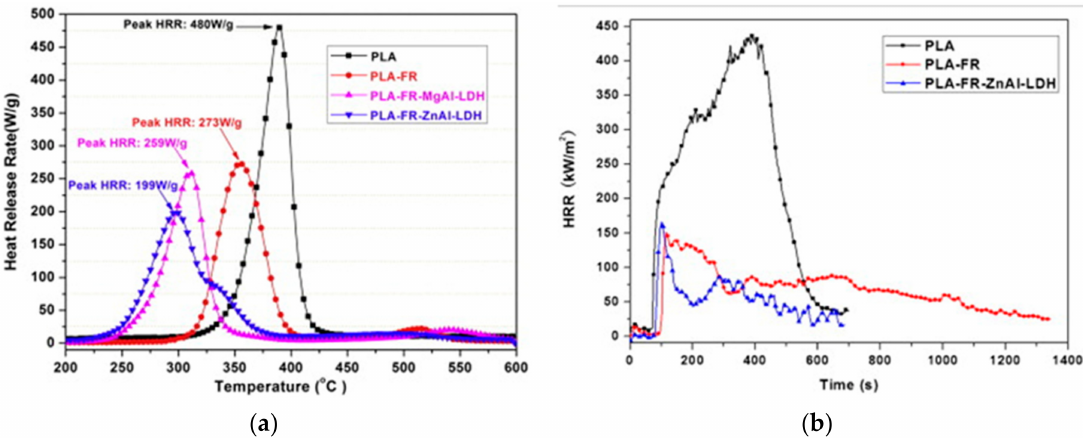
Figure 7. ( a ) Microscale combustion calorimeter PLA/FR/Zn-Al-LDH composite; and ( b ) HRR of PLA/FR/Zn-Al-LDH (Adapted with permission from